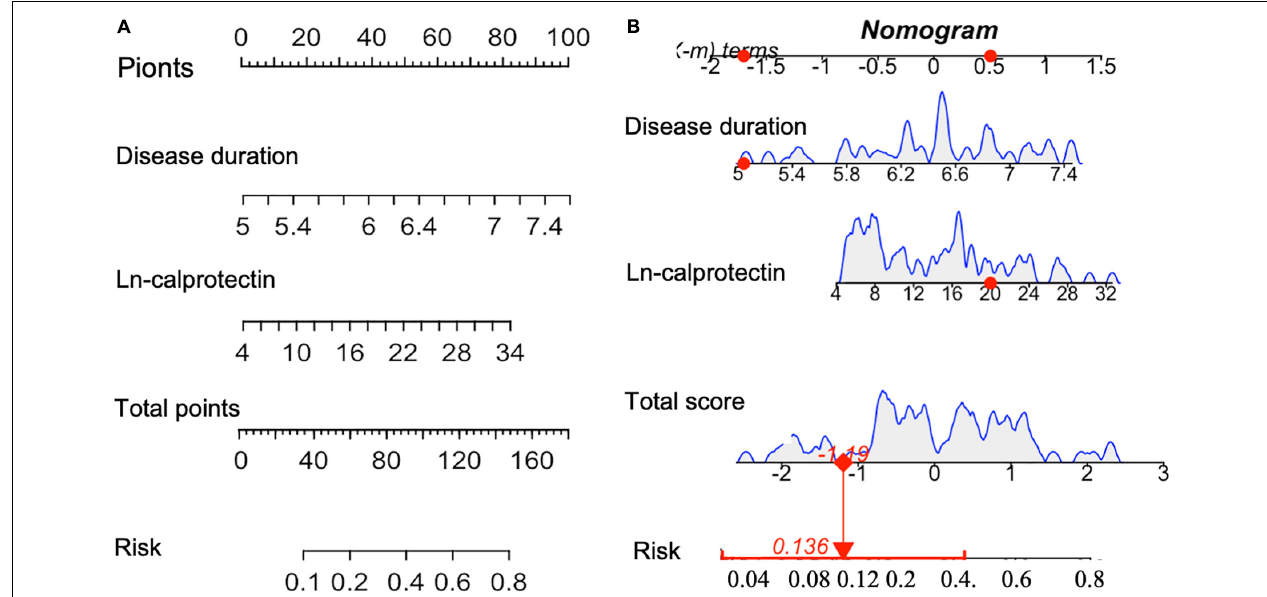
FIGURE 2 | (A) Nomogram for predicting the probability of CP+ including the risk factors of PsA disease duration and Ln-calprotectin. To estimate the risk for the CP+ (shown as “Risk” in the figure) among patients with PsA, each individual patient’s values were plotted on each variable axis. A verticle line was drawn from that value to the top “Points” scale to determine the number of points that were assigned by that variable value. Then, the points from each variable value were summed. The sum on the “Points” scale was located and vertically projected onto the bottom “Total points” axis, and then a personalized risk of CP for PsA was obtained. CP+, the presence of carotid plaque (B) . The dynamic nomogram was used as an example (one patient in our sample).